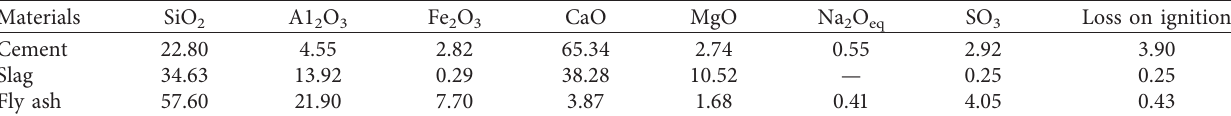
Table 3: Chemical analysis of Portland cement, slag, and fly ash (% by